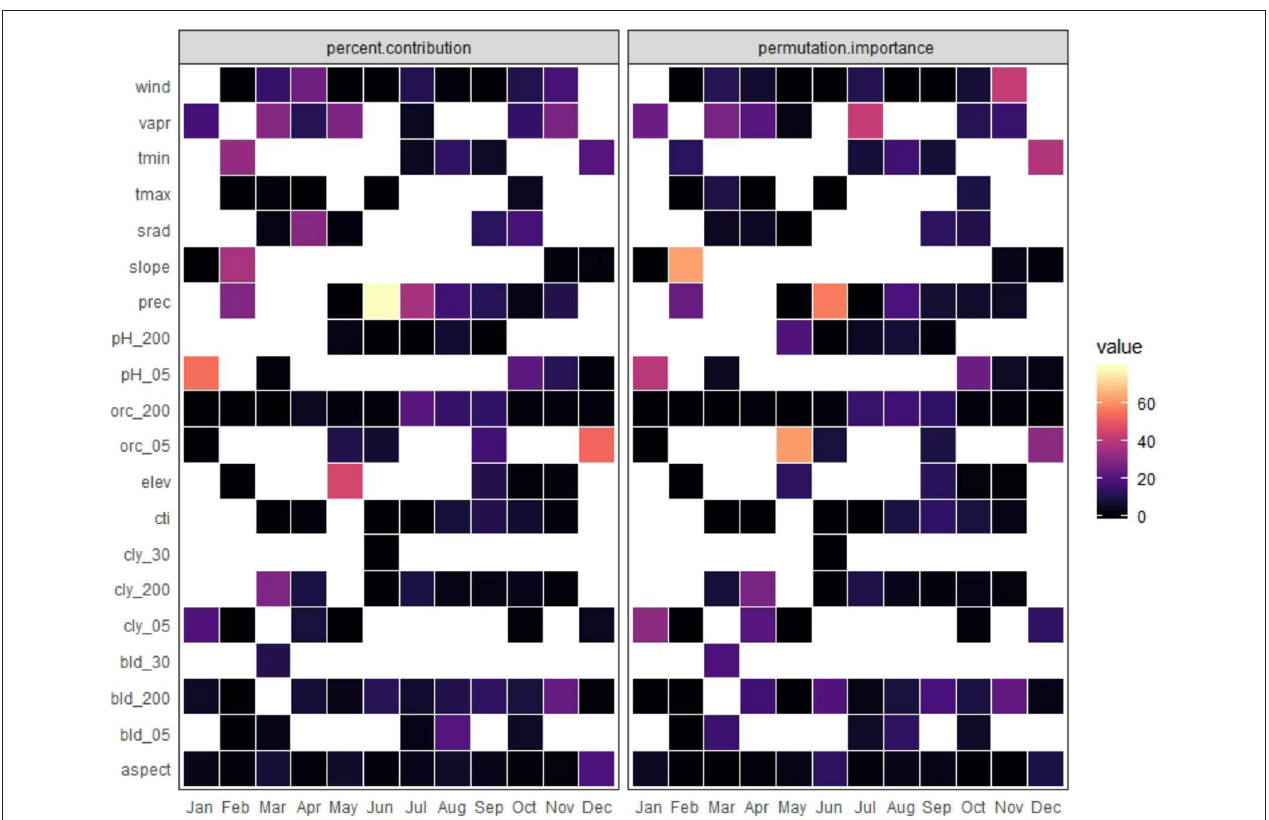
FIGURE 5 | Variables showing percent contribution and permutation importance for each month for the monarch butterfly migratory route; aspect: aspect, bld_05:bulk density at 5cm, bld_30; bulk density at 30cm, bld_200: bulk density at 200cm, cly_05: clay content at 5cm, cly_30: clay content at 30cm, cly_200: clay content at 200cm, cti, compound topographic index; elev, elevation (m); orc_05, organic carbon at 5cm; org_200, organic carbon at 200cm; pH_05, pH at 5cm; pH_200, pH at 200cm; prec, precipitation (mm), slope; srad, solar radiation (kJ m − 2 day − 1 ); tmax, maximum temperature ( ◦ C); tmin, minimum temperature ( ◦ C); vapr, water vapor pressure (kPa); wind, wind speed (m s − 1